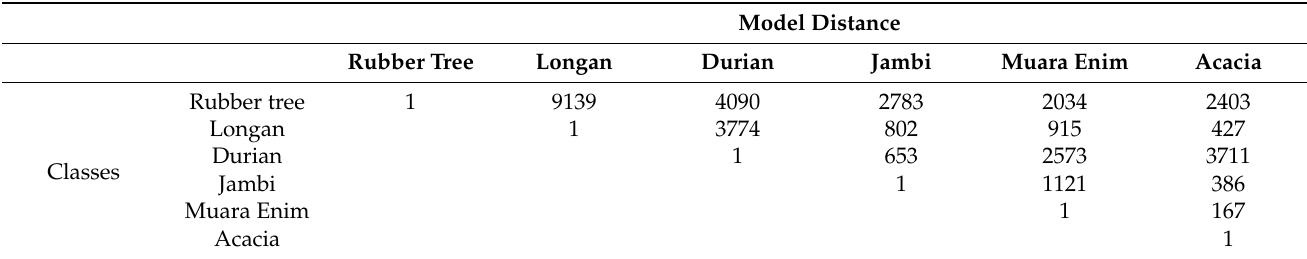
Table 4. Model distance for each class calculated from prediction result using prediction sample